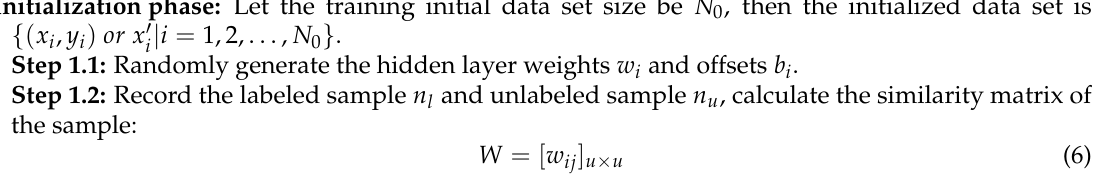
Procedure 1 Semi-Supervised Online Sequential Extreme Learning